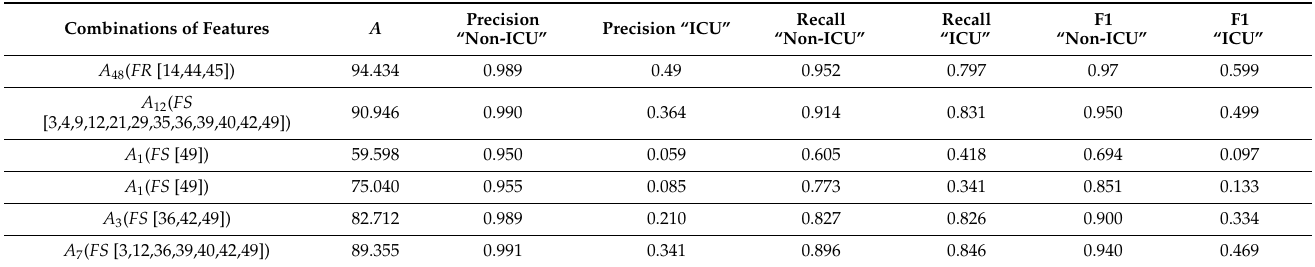
Table 10. LogNNet efficiency for various combinations of features.